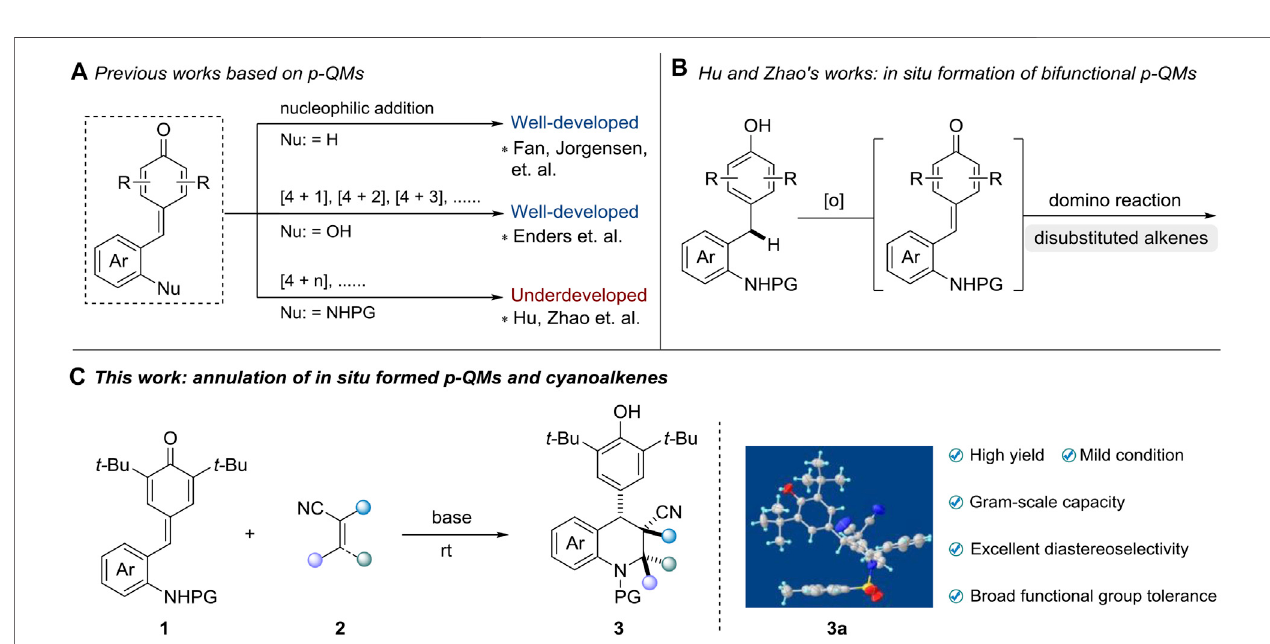
Scheme 1 | Advancements based on functional p -QMs (A, B) and our strategy for synthesis of multi-substituted tetrahydroquinolines (C) .